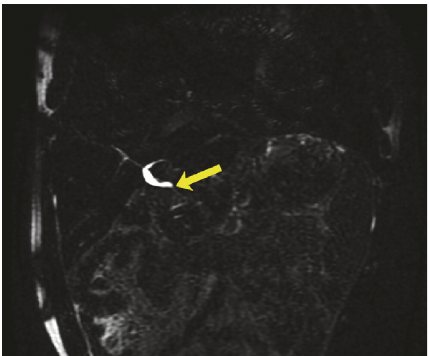
Figure 2: MRI/MRCP showing anastomotic biliary stricture, com- mon hepatic ductal dilatation, and subtle curvilinear filling defect within the common hepatic